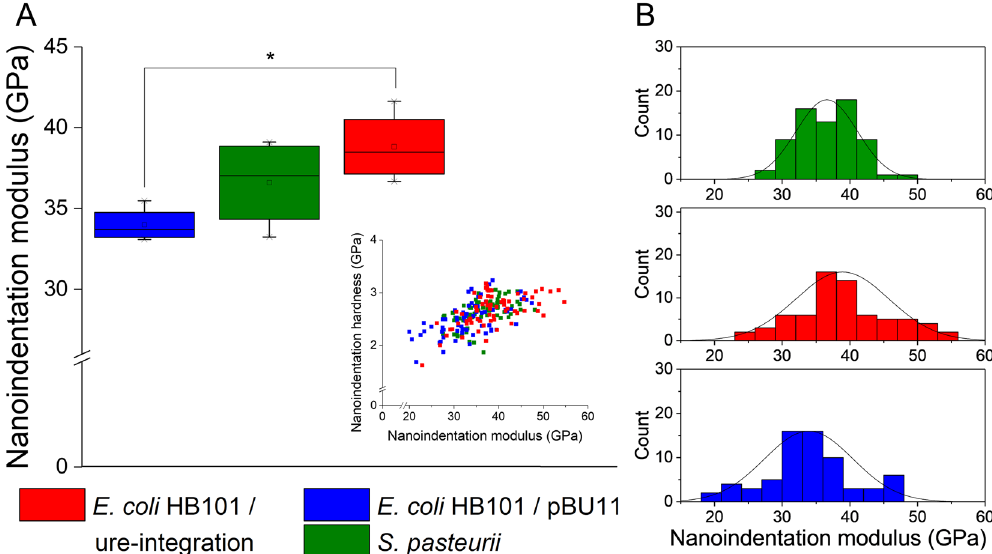
Figure 5. Nanomechanics of biogenic calcite can be tailored with engineered E. coli . ( A ) E i was significantly higher for the engineered E. coli HB101/ure-integration (lower urease activity) compared with E. coli HB101/ pBU11 (higher urease activity). Inset: the ratio of H i to E i does not change with precipitating microorganism, demonstrating that resistance to permanent deformation is not compromised with choice of higher or lower E i . ( B ) Compared with E. coli HB101/pBU11 and S. pasteurii , distributions of moduli for E. coli HB101/ure- integration were shifted towards higher values.